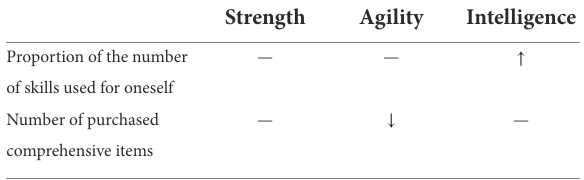
TABLE 6 Changes in job dedication-related behavior indicators as players’ self-regulation increased. Strength Agility